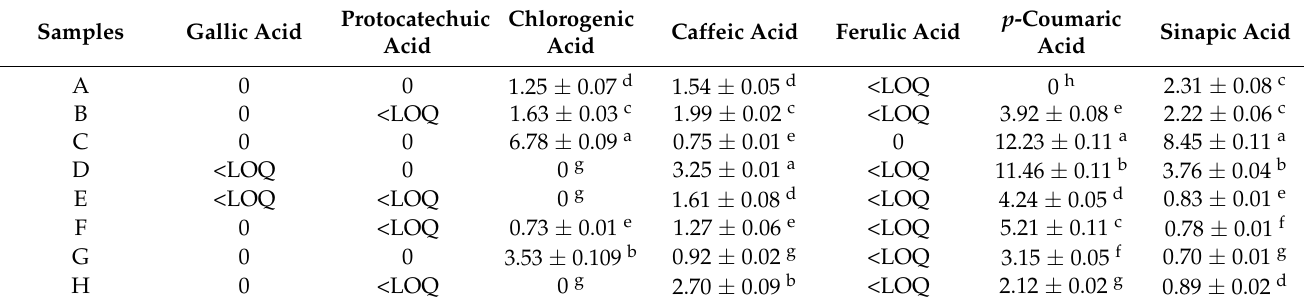
Table 3. Phenolic acids ( µ g/100 g juice) profile of fruit juices prior to in vitro digestion